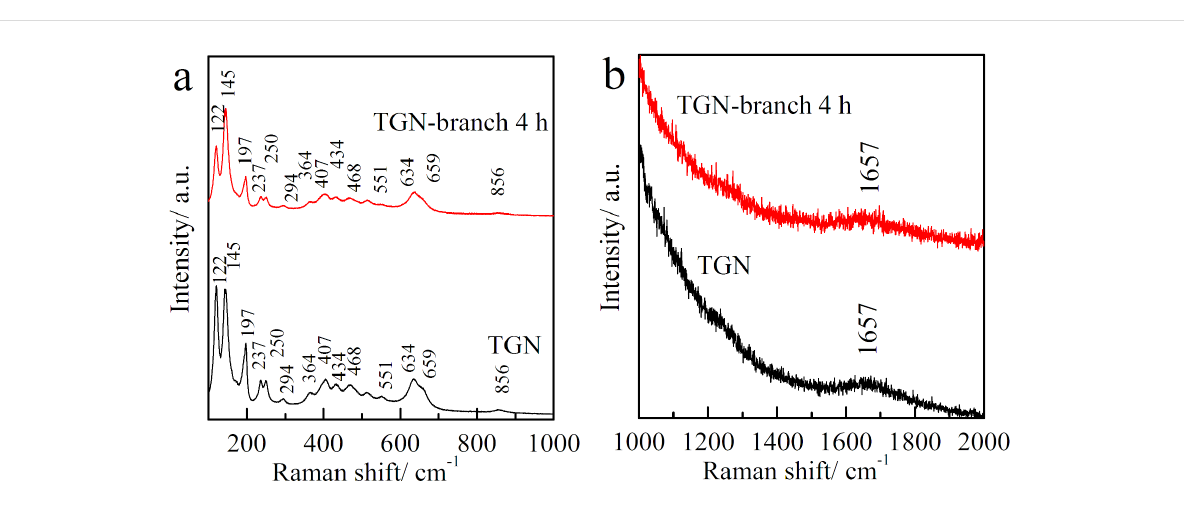
is due to the decreased ratio of rGO in TGN after growing